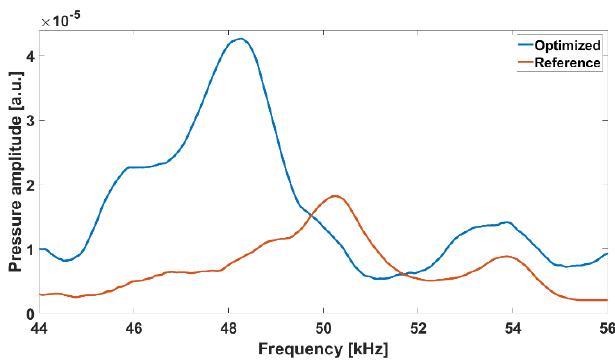
Figure 12. Frequency response plot of the reference resonator with the optimized resonator.